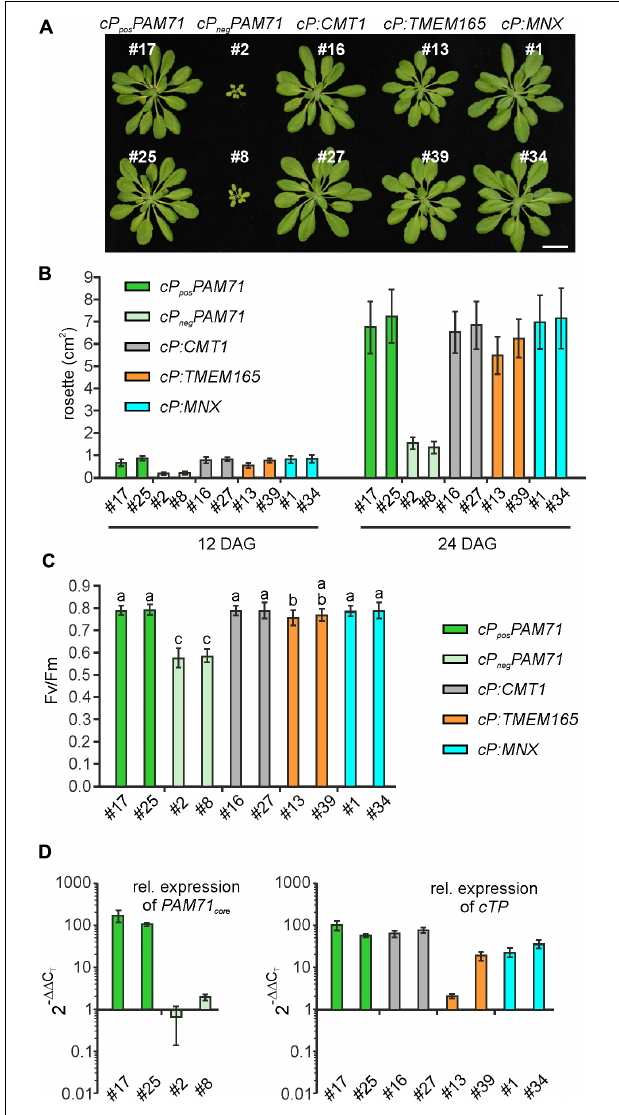
FIGURE 4 | Growth phenotype, photosynthetic activity and expression of transgenes in individual transgenic lines with pam71 genetic background. (A) Rosette phenotype of the indicated transgenic lines. Plants were grown for 5 weeks in a 12–12 h light-dark cycle. Scale bar = 2 cm. (B) Quantification of growth phenotypes of the indicated transgenic lines. Leaf areas of the different genotypes were determined from photographs taken 12 days after germination (DAG) and 24 days after germination (DAG). Mean values ± SD ( n = 10) are shown. (C) Photosynthetic activity of the indicated transgenic lines. Maximum quantum yields of PSII (Fv/Fm) are shown as mean values ± SD ( n ≥ 17). Plants were grown for 4 weeks on a 12–12 h light-dark cycle at 100 µ mol photons m − 2 s − 1 . Different letters indicate statistical significance according to ANOVA ( p < 0.05, Tukey’s HSD test). (D) Expression analysis in transgenic lines. The color code for genotypes is identical to that in panels (B,C) . Quantitative real-time PCR (qRT-PCR) was performed using primer combinations qRT_PAM71_fwd/qRT_PAM71_rev ( Supplementary Table 1 ) for expression of PAM71 core and qRT_PAM71cTP_fwd/qRT_PAM71cTP_rev ( Supplementary Table 1 ) for expression of cTP PAM 71 . Expression levels are relative values based on the expression levels in Col-0 (= 1), and Actin2 as reference gene. Mean values ± SD are based on three biological